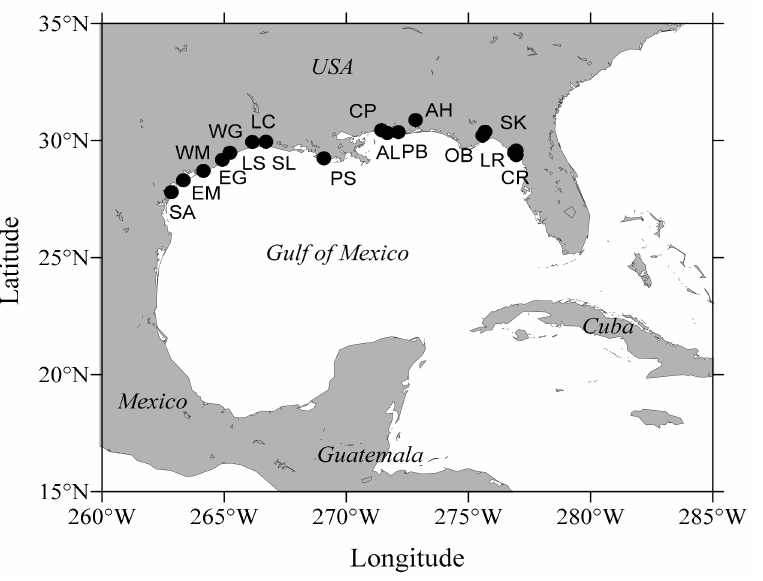
Figure 1. Schematic map showing Eastern oyster Crassostrea virginica 17 collection sites (in or- der of decreasing longitude) along the Gulf of Mexico). Florida : Corrigan Reef (CR), Lone Cabbage Reef (LR), Seahorse Key (SK), Oyster Bay (OB), Alligator Harbor (AH) and Pensacola Bay (PB). Alabama : Alonzo Landing (AL) and Cedar Point (CP). Mississippi: Pascagoula (PS). Louisiana : Sister Lake (SL) and Lake Calcasieu (LC). Texas : Lake Sabine (LS), West Galveston Bay (WG), East Galveston Bay (EG), West Matagorda Bay (WM), East Matagorda Bay (EM) and San Antonio Bay